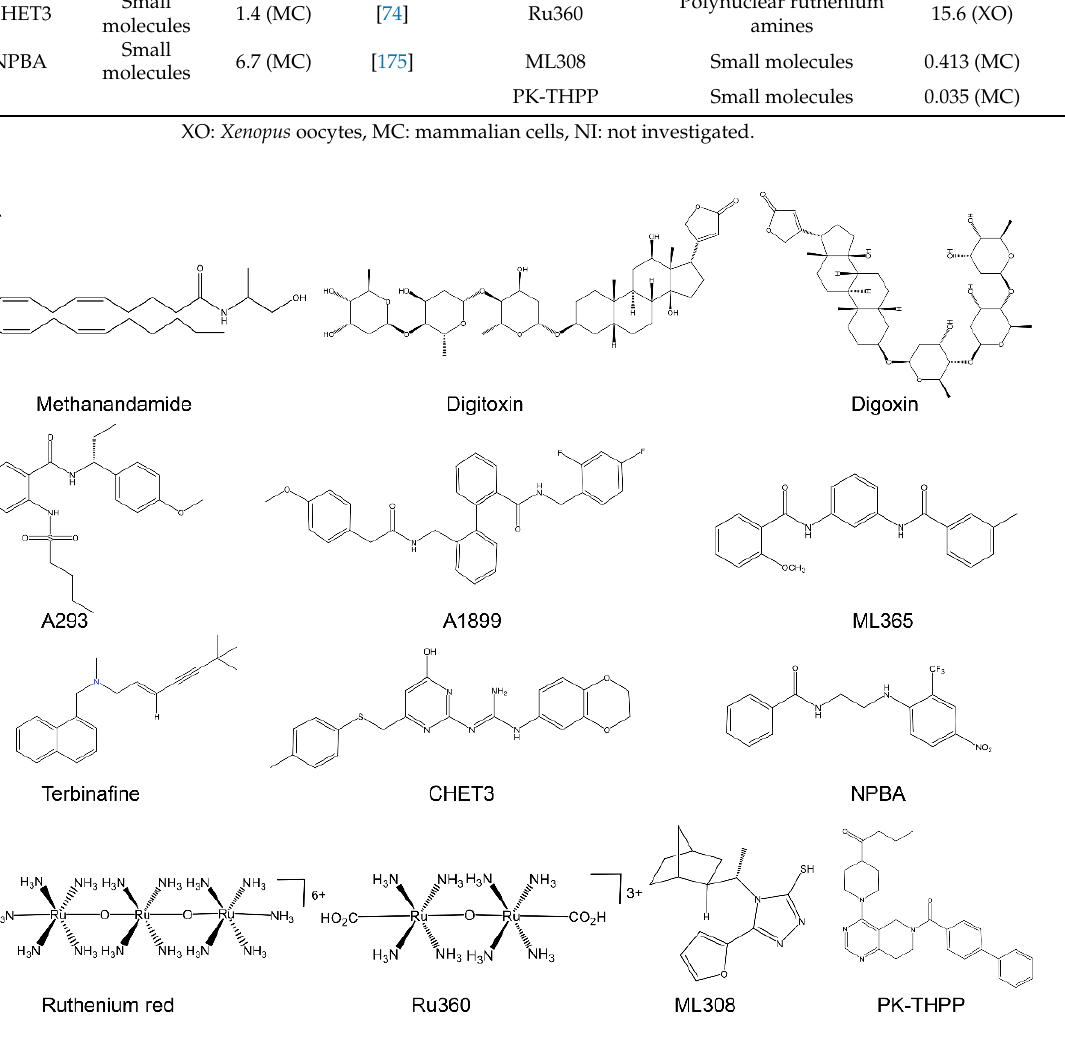
Figure 3. Chemical structures of compounds that target TASK-1 and TASK-3 channels. ( A ) The chemical structures of inhibitors targeting TASK-1 channel. ( B ) The chemical structures of activators targeting TASK-3 channel. ( C ) The chemical structures of inhibitors targeting TASK-3 channel.